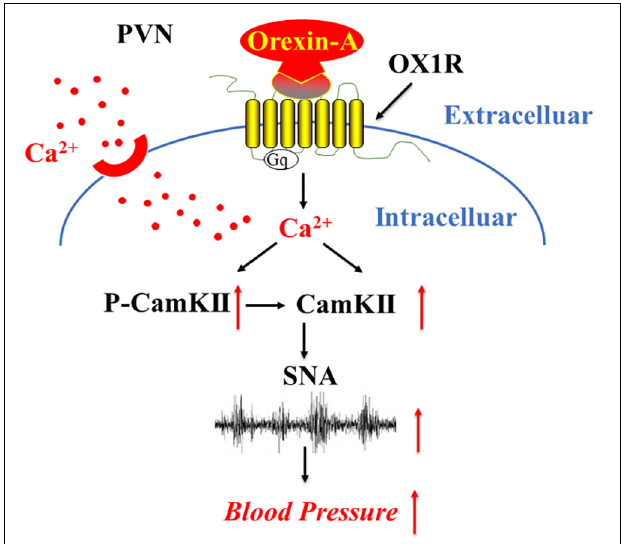
FIGURE 7 | A proposed mechanism that OX1R activation on sympathetic nerve activity and blood pressure regulation. Binding of orexin-A with OX1R results in OX1R activation, which in turn triggers the influx of Ca 2 + resulting in intracellular Ca 2 + increase. Ca 2 + , in turn, activates CaMKII enzyme activity as well as CaMKII expression, which eventually results in SNA increase and blood pressure